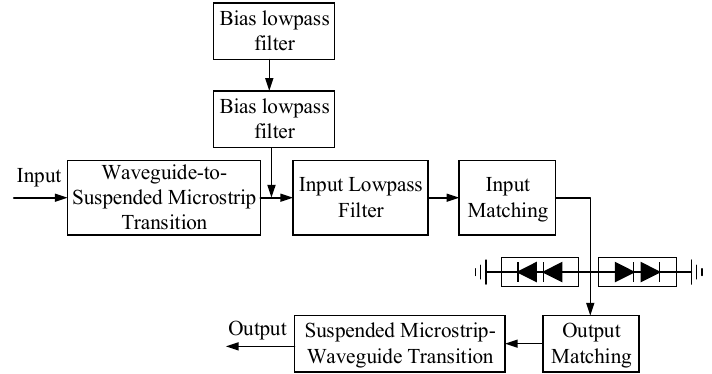
Figure 14. Schematic of the 220 GHz tripler circuit.